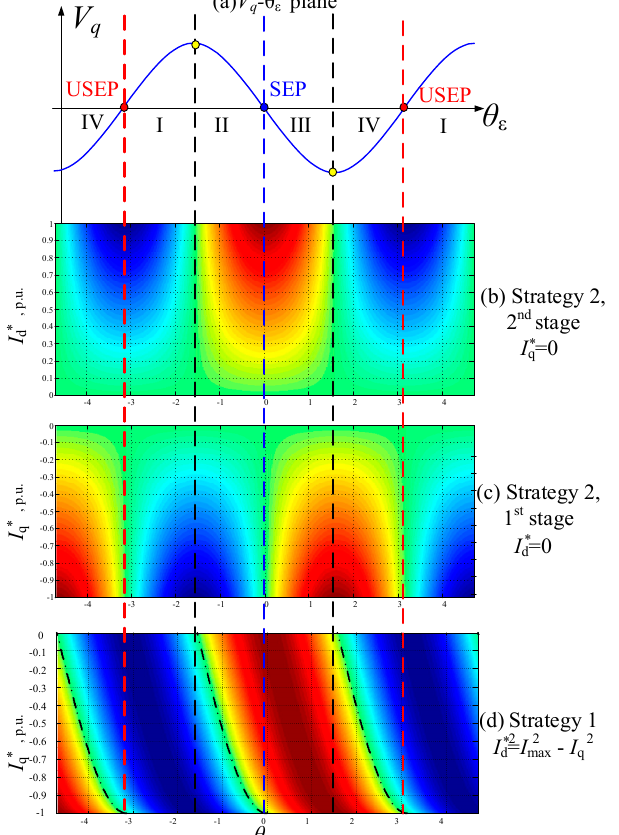
Figure 9. ( a ) V q versus phase deviation, ( b ) heat map of 2nd stage of strategy 2, ( c ) heat map of 1st stage of strategy 2, ( d ) heat map of strategy 1.